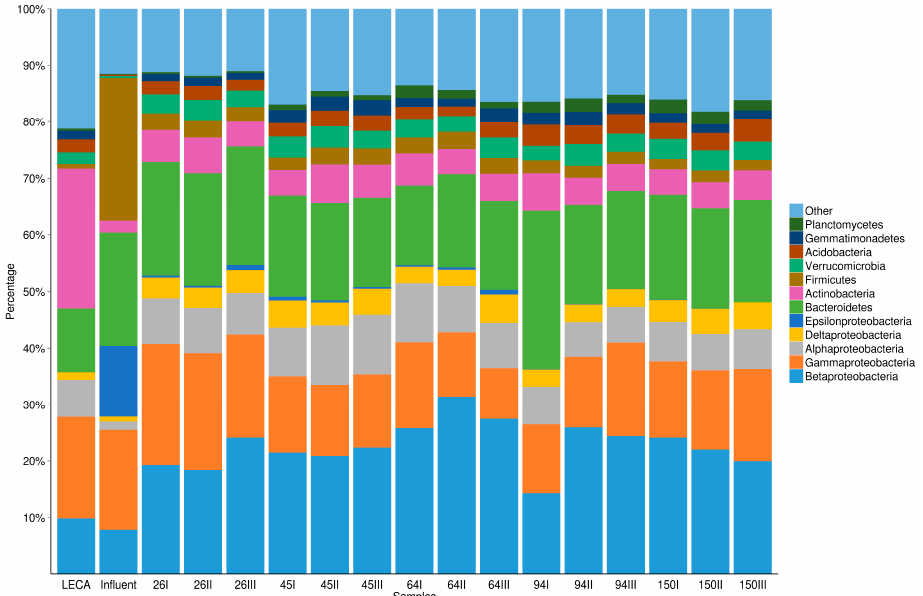
Figure A3. The bacterial community taxonomy of initial light expanded clay aggregates (LECA), influent of HSSF mesocosms (MCs) on day 26 of the experiment, and wetland media biofilm (days 26–150) at phylum level. Proteobacteria is presented at class level. Arabic numerals in symbols indicate days of system operation and Roman numerals indicate parallel mesocosms.